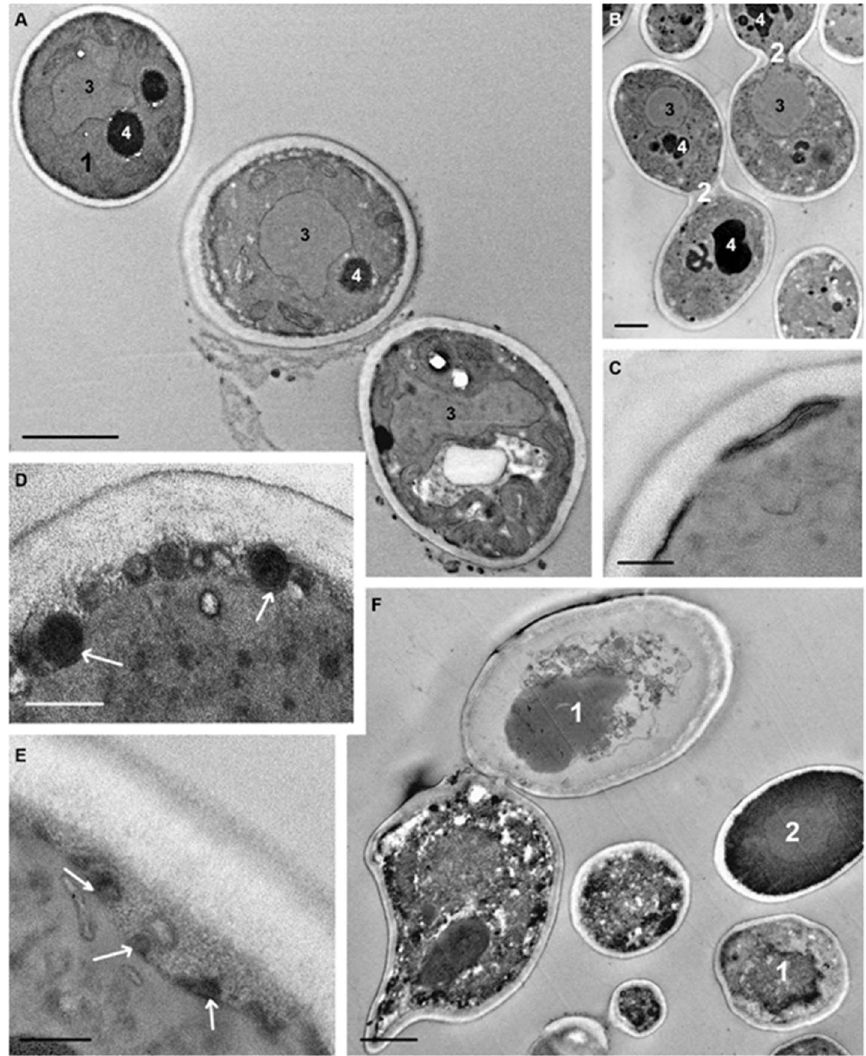
Figure 8. Changes in ultrastructure of C. albicans incubated for 75 min with peptide (KFF)3K. ( A , B ) diversity of cell morphological changes: 1 –a cell with minimal destructive changes; 2 –budding cells; 3 –nucleus; 4 –vacuole. ( C ) osmiophilic material on the cell surface. ( D ) multilayer “balls” on the border of the plasma membrane and the cell wall (shown by arrows). ( E ) membrane “balls” in the expanded space between the cell wall and the cell. ( F ) necrotic ( 1 ) and “normal” ( 2 ) C. albicans cells after 6 h of incubation with peptide (KFF)3K. ( A – E ) sections without contrasting. Scale bars correspond to 1 µ m ( A , B , F ) and 200 nm ( C – E